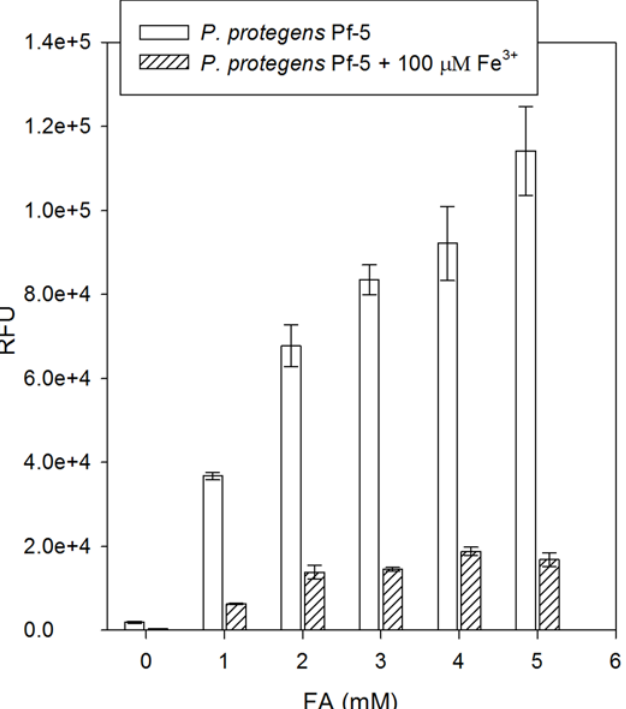
Figure 5. Effect of FA and iron supplementation on pyoverdine production. P. protegens Pf-5 was cultured aerobically during 16 h in 96-well polystyrene plates containing E 2 glucose minimal medium with or without increasing concentrations of FA and with or without FeCl 3 supplementation at a final concentration of 100 μ M. The fluorescence intensity of the supernatant was measured with a fluorimeter and growth was estimated by determination of the OD 600 . The fluorescence intensity obtained was normalized to the OD 600 , and is thus expressed in relative fluorescence units (RFU). The experiments were performed three times and error bars represent the standard deviation of the mean.